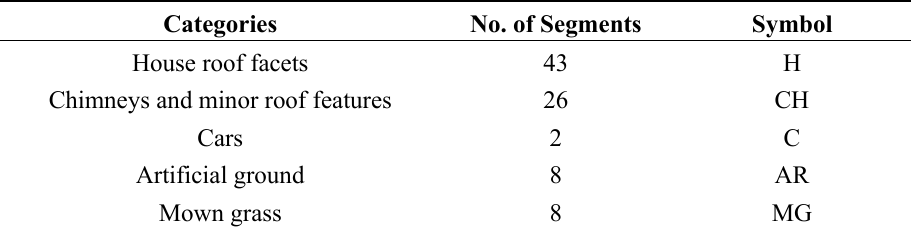
Table 4. Error matrix categories and their corresponding